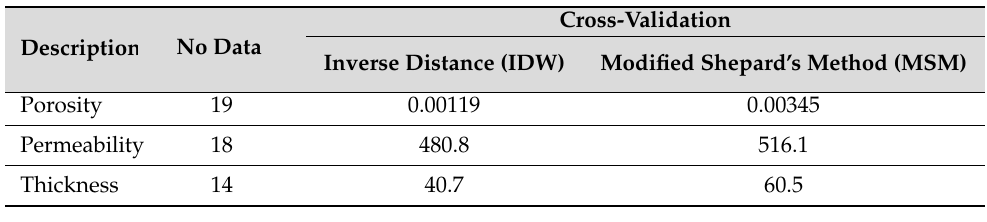
Table 3. Summary results of application of the IDW and MSM methods in reservoir